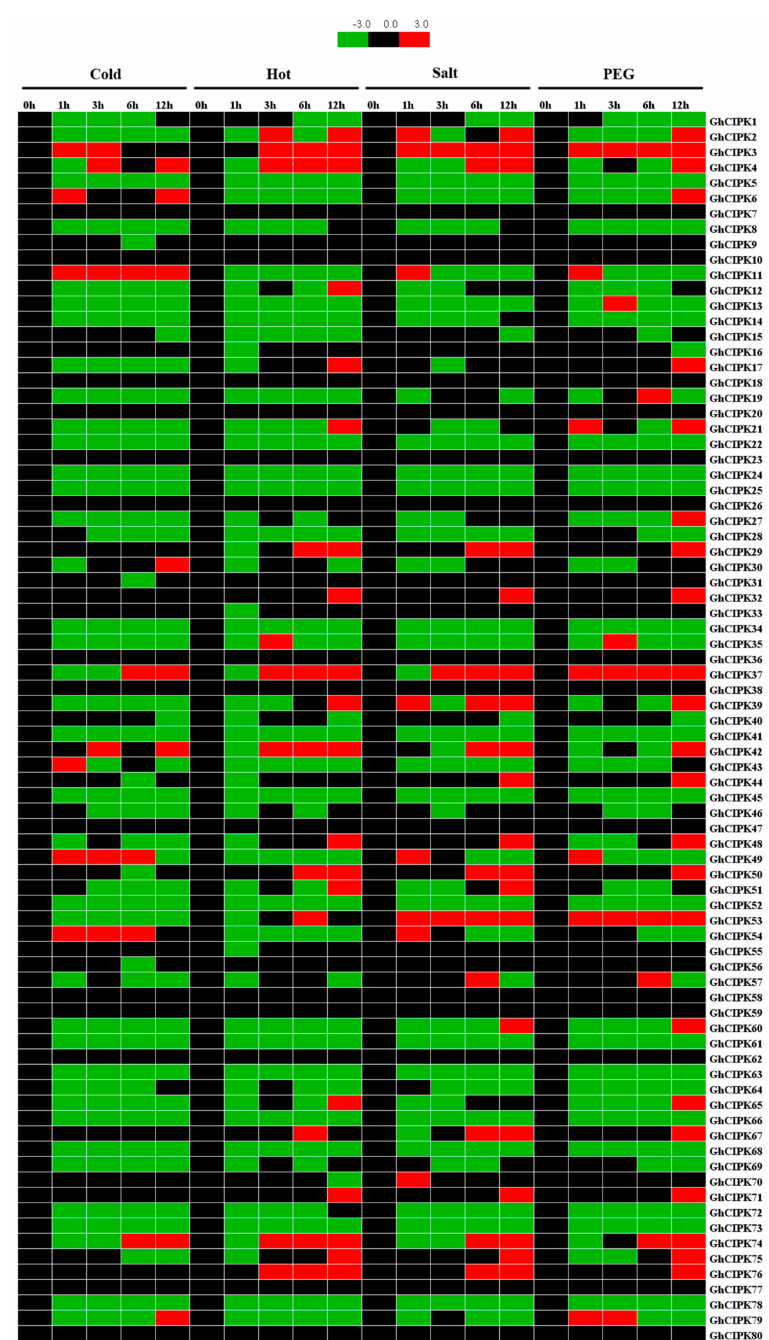
Figure 5. Expression patterns of 80 ChCIPK genes in response to various stresses. The colored bar represents the relative expression